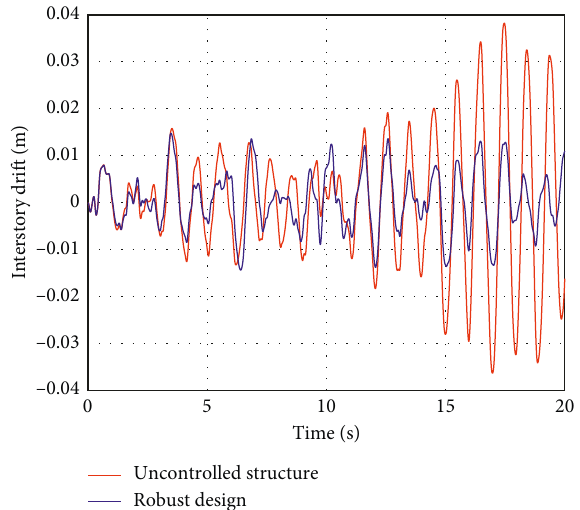
Figure 4: Interstory drift at first story for uncontrolled structure (red curve) and controlled structure (blue